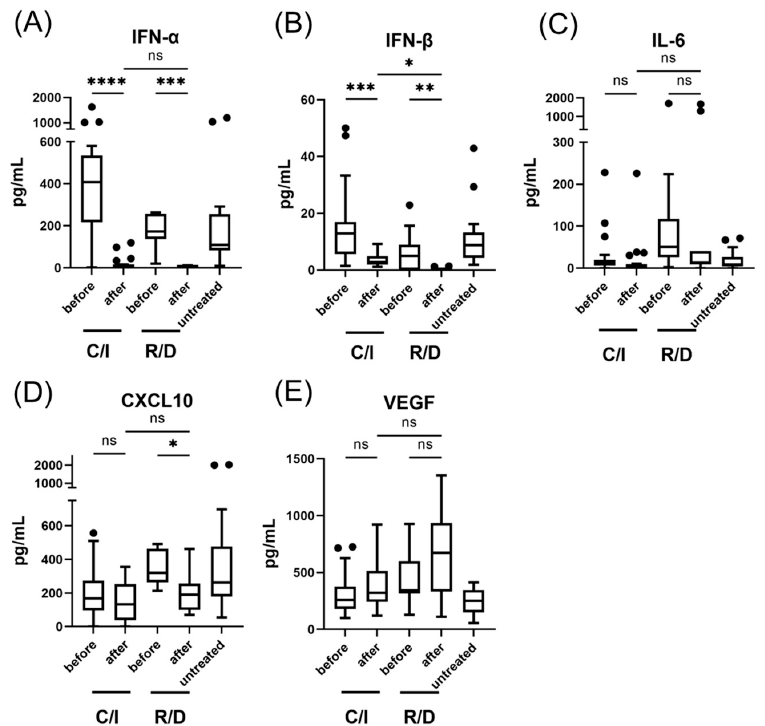
Figure 3. Serum type I IFN and pro-inflammatory cytokine levels in patients with SARS-CoV-2 infection, treated in the early phase (within 5 days after the onset of symptom); IFN- α levels ( A ), IFN- β levels ( B ), IL-6 levels ( C ), CXCL10 levels ( D ), and VEGF levels ( E ). Each level was evaluated at the time point before and after the treatment; within 24 h before the initiation of therapy, 3 days after C/I administration or 5 days after R/D initiation. Data are presented as Tukey boxplots and individual values. Nonparametric Mann–Whitney test with Bonferroni correction was used to compare values between groups. *, p < 0.05. **, p < 0.005. ***, p < 0.001. ****, p < 0.0001. C/I, casirivimab/imdevimab group; IFN, interferon; ns, not significant; R/D, remdesivir/dexamethasone